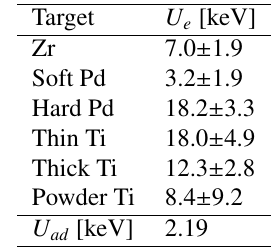
Table 1. The electron screening potentials U e measured in the 2 H( 19 F,p) 20 F reaction in six di ff erent targets in comparison with the predicted screening potential given by the adiabatic